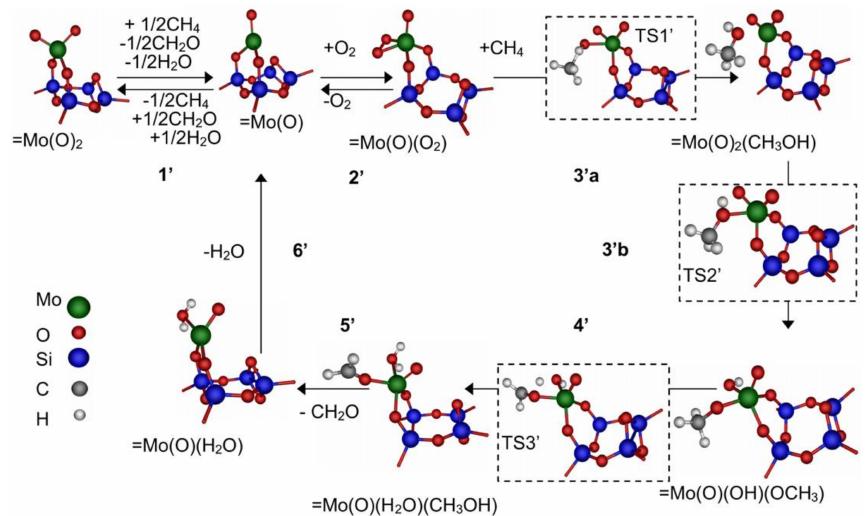
Figure 5. Proposed reaction mechanism based on the assumption of =Mo(O) 2 as the active center. Transition state structures are enclosed within dotted lines [47]. Copyright 2007, with permission from